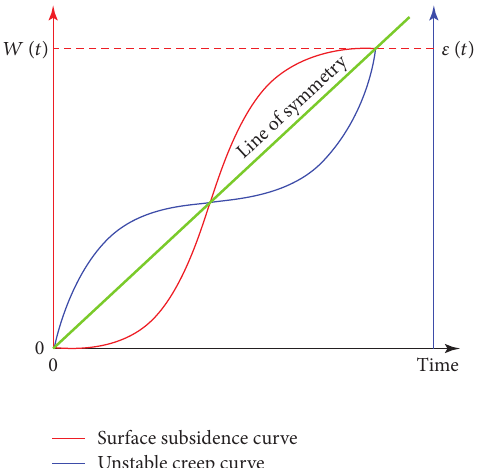
Figure 2: Unstable creep and surface subsidence